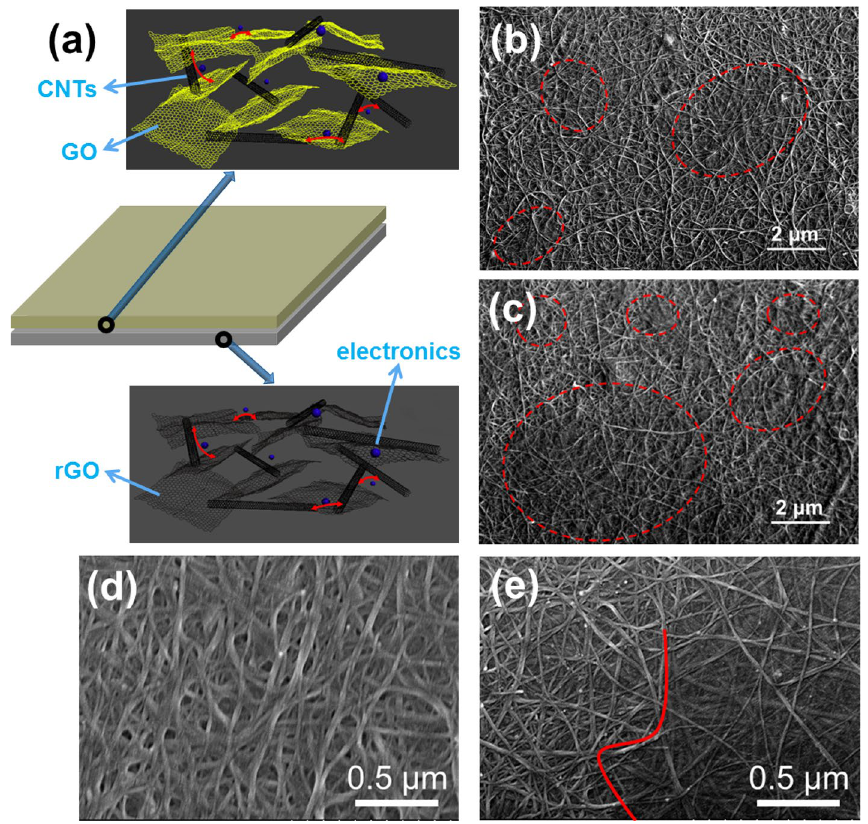
Figure 8. ( a ) Structural schematic map of S-RGO/CNT* films containing CNTs, GO, and rGO. SEM pictures of films with a bilayer structure: ( b ) S-RGO/CNT0.5; ( c , e ) S-RGO/CNT1.0. ( d ) pure CNT film.